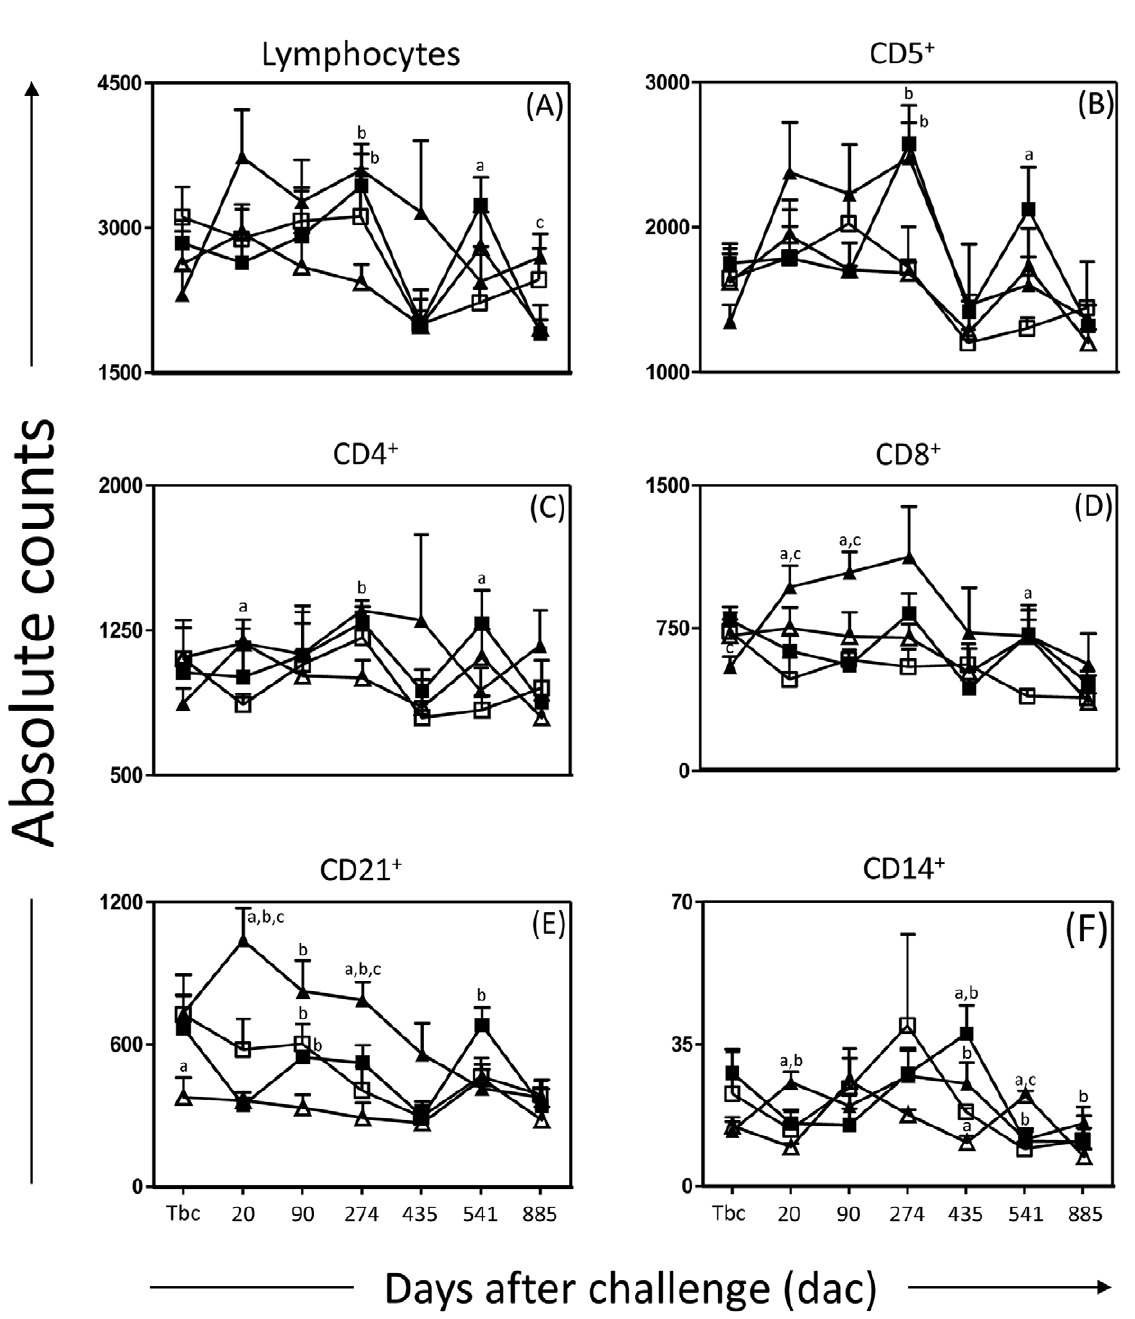
Figure 2. Cellular profile of circulating lymphocytes and monocytes in dogs submitted to different vaccination protocols before and after challenge with L.infantum plus SGE. C (control; white square); Sap (saponin; white triagle); LB (killed L. braziliensis vaccine; black square), LBSap (killed L. braziliensis vaccine plus saponin; black triagnle): the x -axis displays the times at which the assays were conducted (Tbc: time before challenge with L . infantum ; and 20, 90 274, 435, 541 and 885 days after challenge [dac] with L . infantum ), and the y -axis represents the mean values of the (A) absolute counts of circulating lymphocytes and of (B) CD5 + , (C) CD4 + , (D) CD8 + , (E) CD21 + cells and (F) CD14 + monocytes. Significant differences ( p , 0.05) between the LBSap group and the control C, Sap and LB groups are indicated, respectively, by the letters a, b and